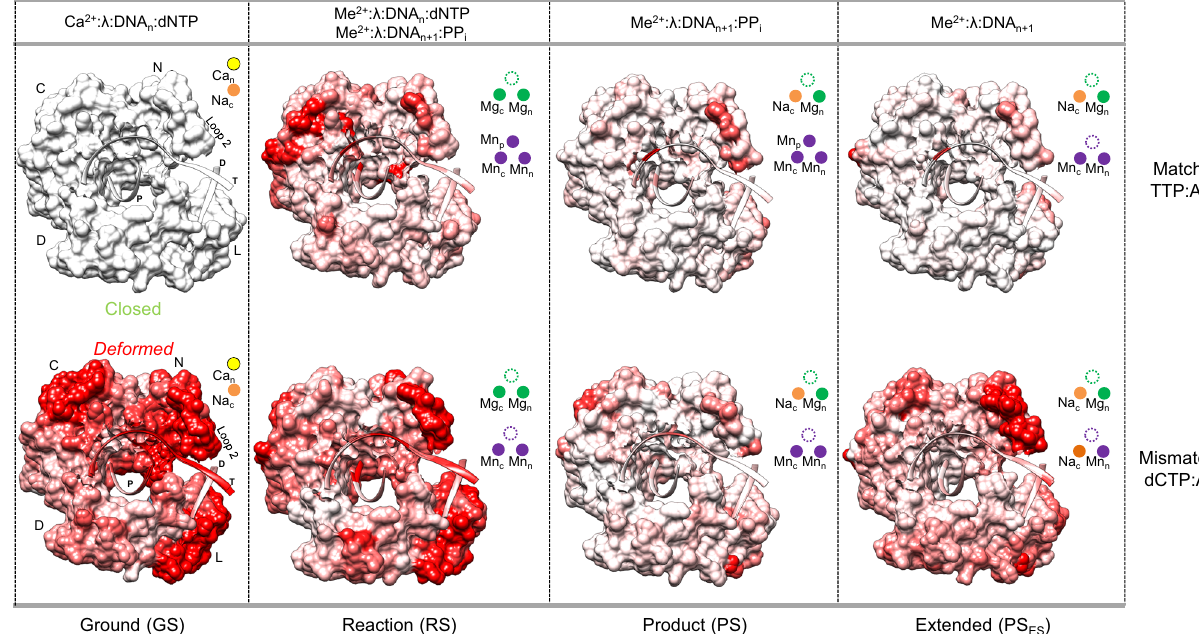
Fig. 7 Hidden pol λ fi delity mechanisms. Panels display structural intermediates corresponding to the stage of nucleotide incorporation indicated below. Ligands observed at each stage of reaction are indicated above the central panels. “ Closed ” and “ Deformed ” refer to the state of the polymerase in matched and mismatched insertion, respectively. Regions of the protein or DNA shaded from white (0 Å) to red (1 Å and above) display differences in positions of backbone C α atoms compared to the previous intermediate (RS compared to GS, PS compared to RS, and PS ES compared to PS). Shading of the mismatched ground state complex from white (0 Å) to red (1 Å and above) re fl ects differences in C α positions compared to the matched ground state ternary complex. The catalytic (Me c ), nucleotide (Me n ) and product metals (Mn p ) are indicated by spheres colored according to metal identity (Ca 2 + , yellow; Na + , orange; Mg 2 + , green; Mn 2 + , magenta). Protein subdomains are labeled as the N (thumb), C (palm), D ( fi ngers) and L (lyase) domains. Superimposition and shading was performed with the program Chimera by overlaying the palm domains (residues 386 – 494) of each